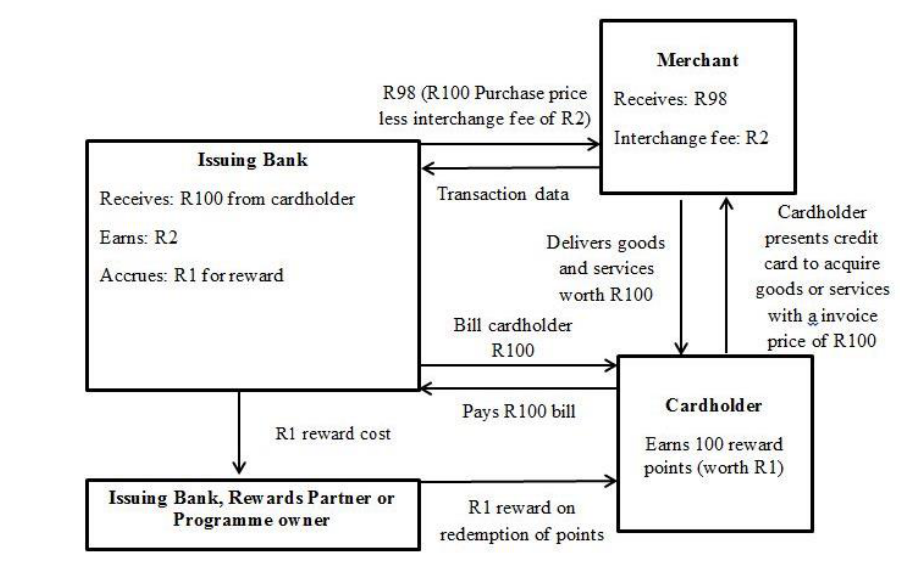
FIGURE 2: Closed loop structure Source: Payments-R-Us,